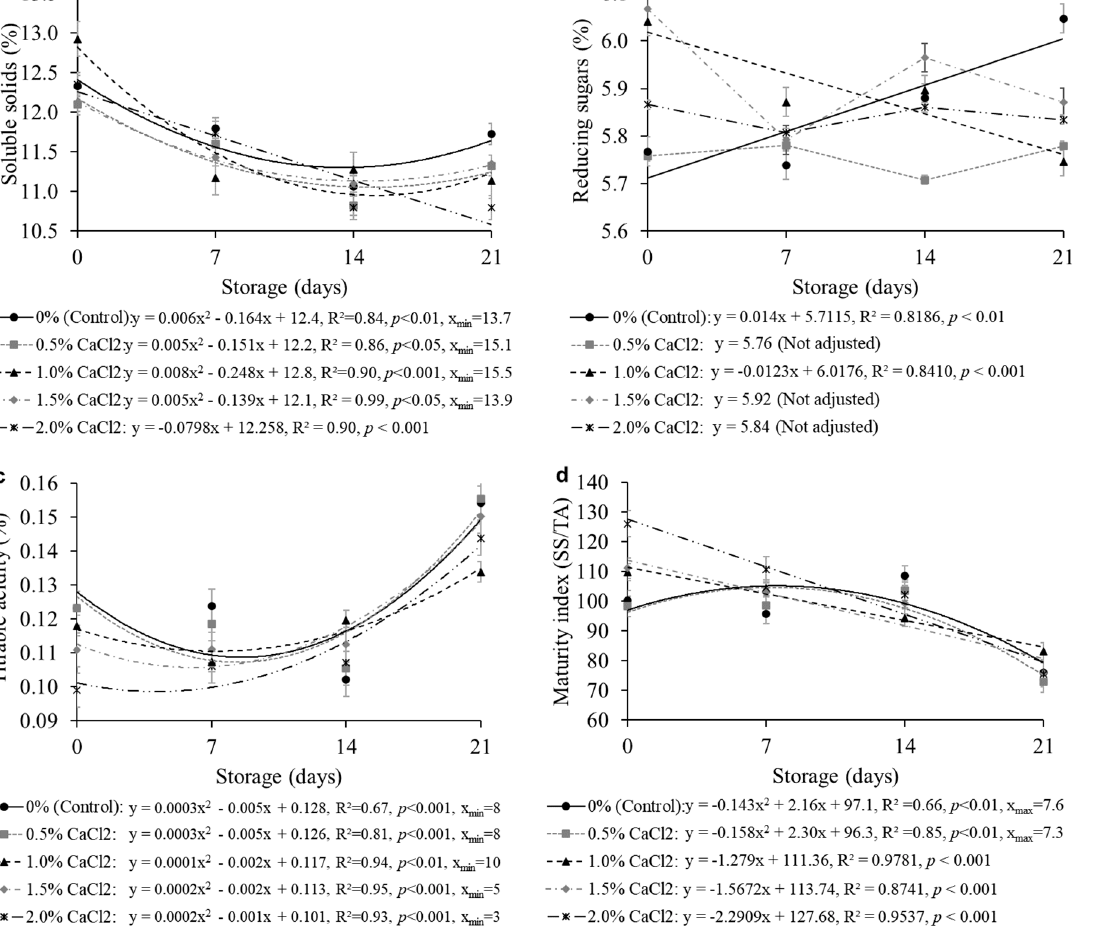
Figure 6. Soluble solids ( a ), reducing sugars ( b ), titratable acidity ( c ) and maturation index ( d ) of ‘Roxo de Valinhos’ fig fruits as a function of CaCl 2 concentrations and storage days at 5 ± 1 °C and 90–95% R.H. Bars symbolise standard errors (n = 4).